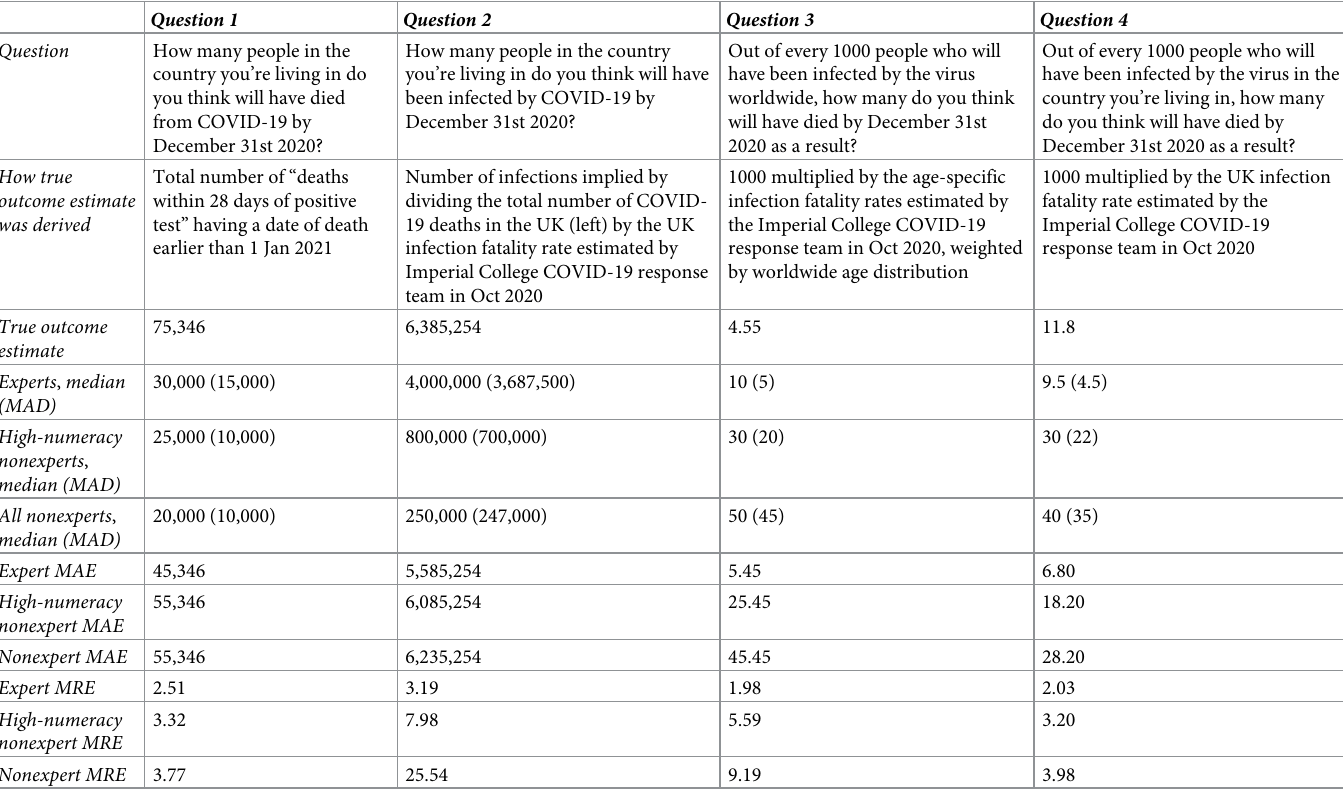
Table 1. Questions asked of participants with corresponding forecast medians, median absolute deviation (MAD), median absolute error (MAE) and median rela- tive error (MRE). Question